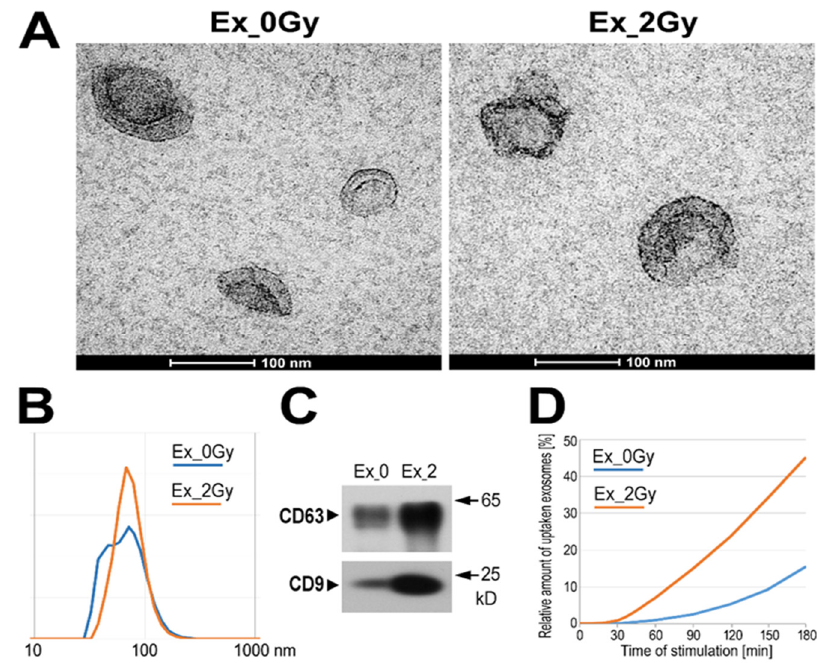
Figure 1. Characteristics of exosomes: TEM imaging of vesicles ( A ); size of vesicles assessed by DLS measurement ( B ); and the presence of exosome markers ( C ) in total sEVs released by mock- irradiated FaDu cells (Ex_0Gy) and cells irradiated with 2 Gy dose (Ex_2Gy); ( D ) relative amounts of internalized vesicles based on the accumulation of exosome membrane-bound dyes (expressed as a percentage of a dye level noted after 6 h of co-incubation).